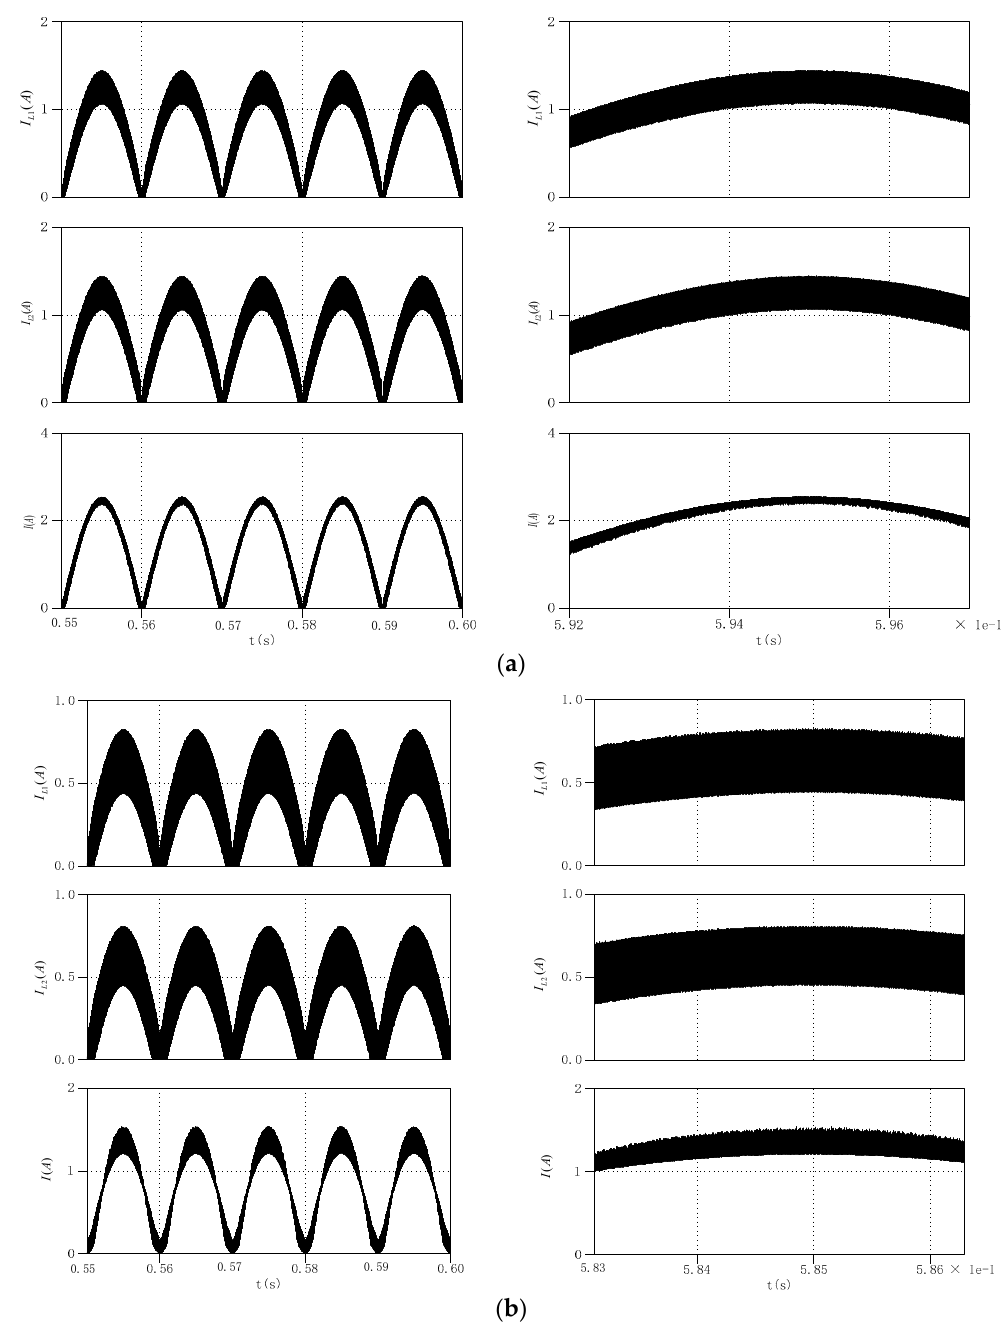
Figure 7. Inductor currents and input current with J-A model consideration; ( a ) V in = 110 V; and ( b ) V in = 220 V.